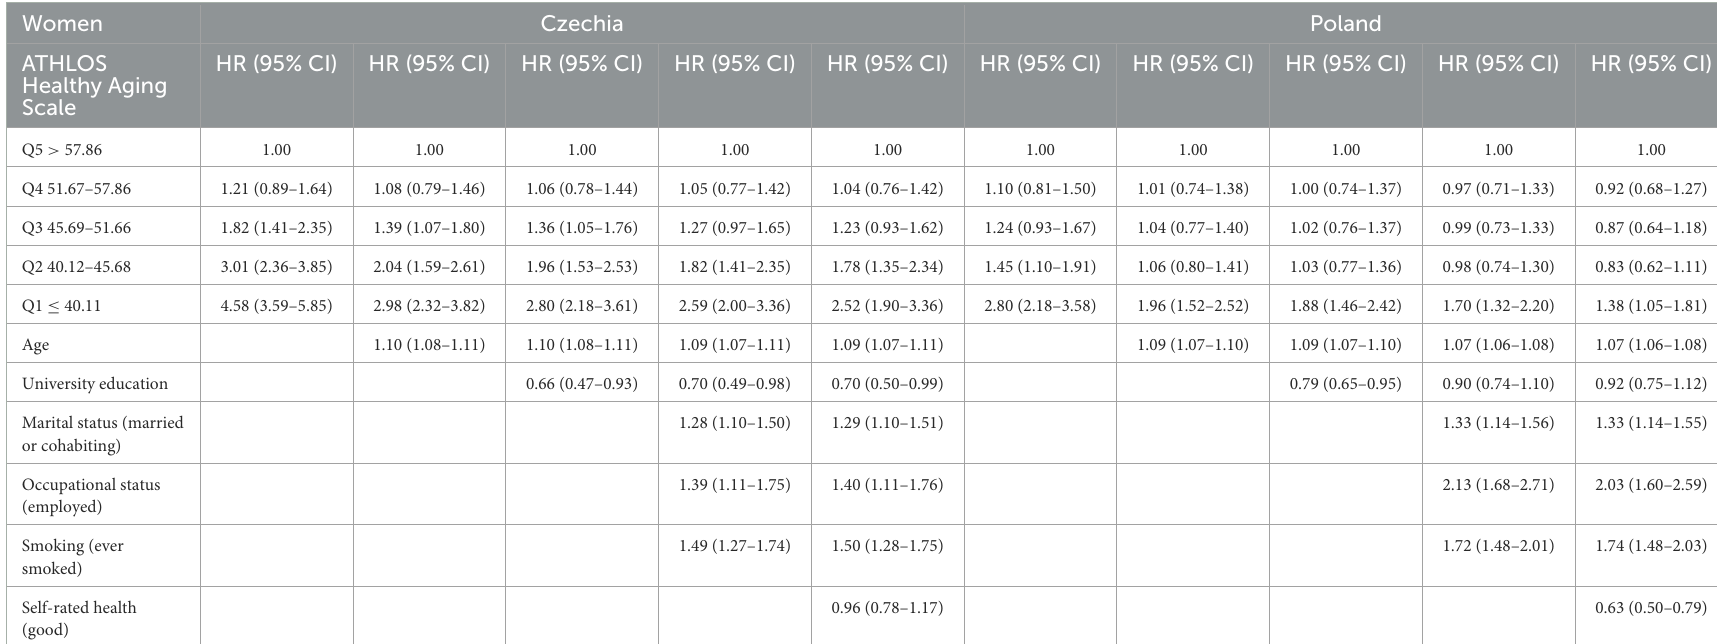
TABLE 3 Association between quintiles of ATHLOS Healthy Aging Scale score and all-cause mortality by country for the women.